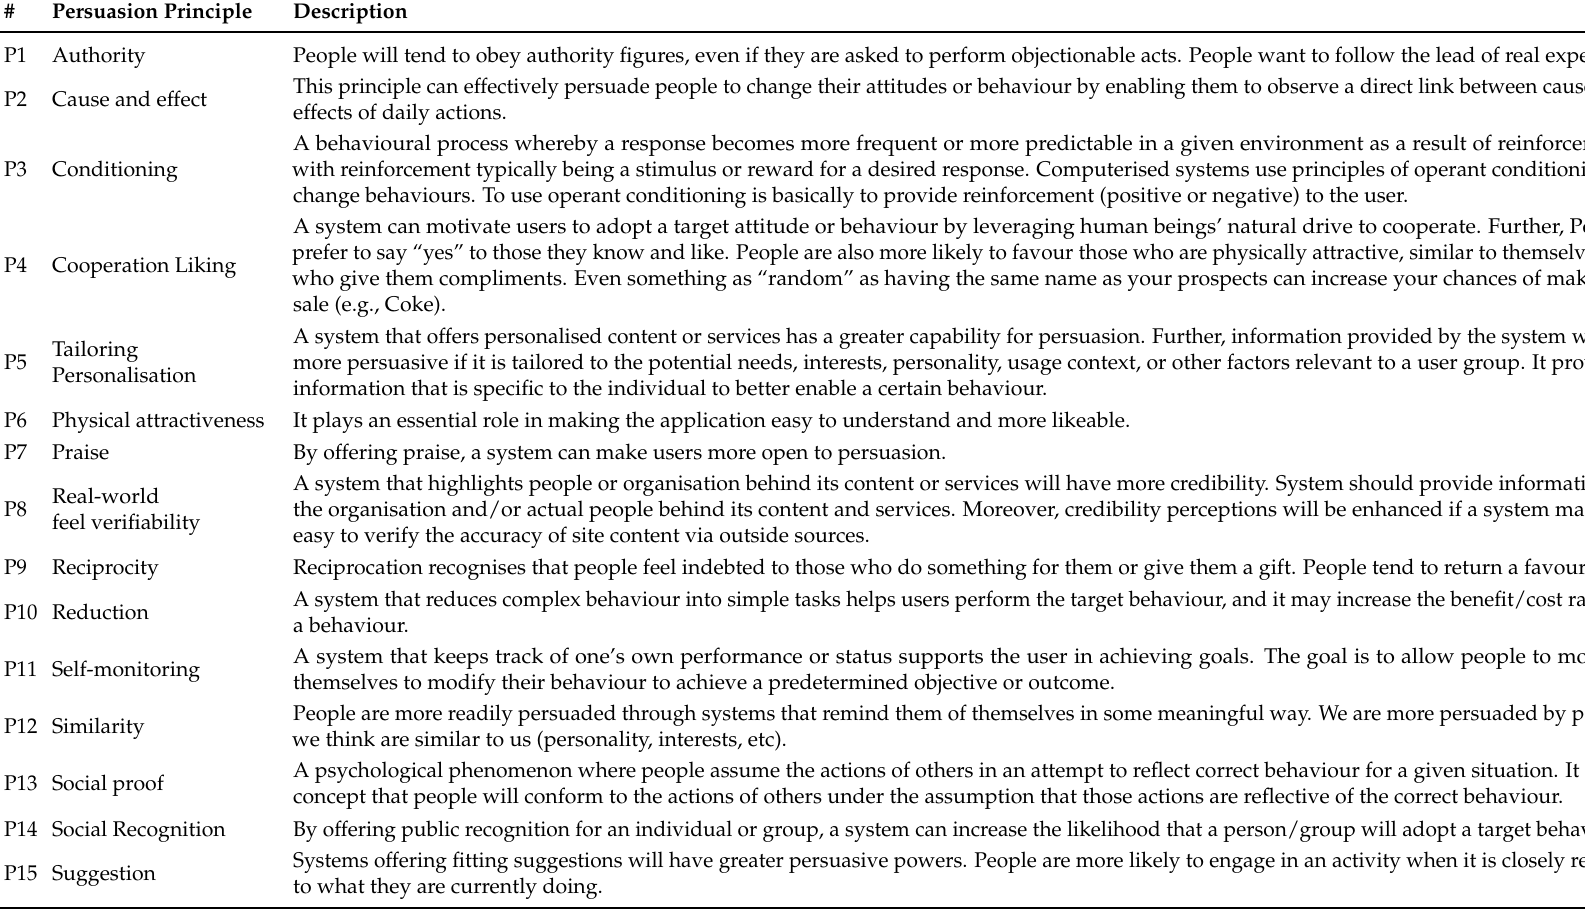
Table 1. Explanation and Rationale of 15 Persuasion